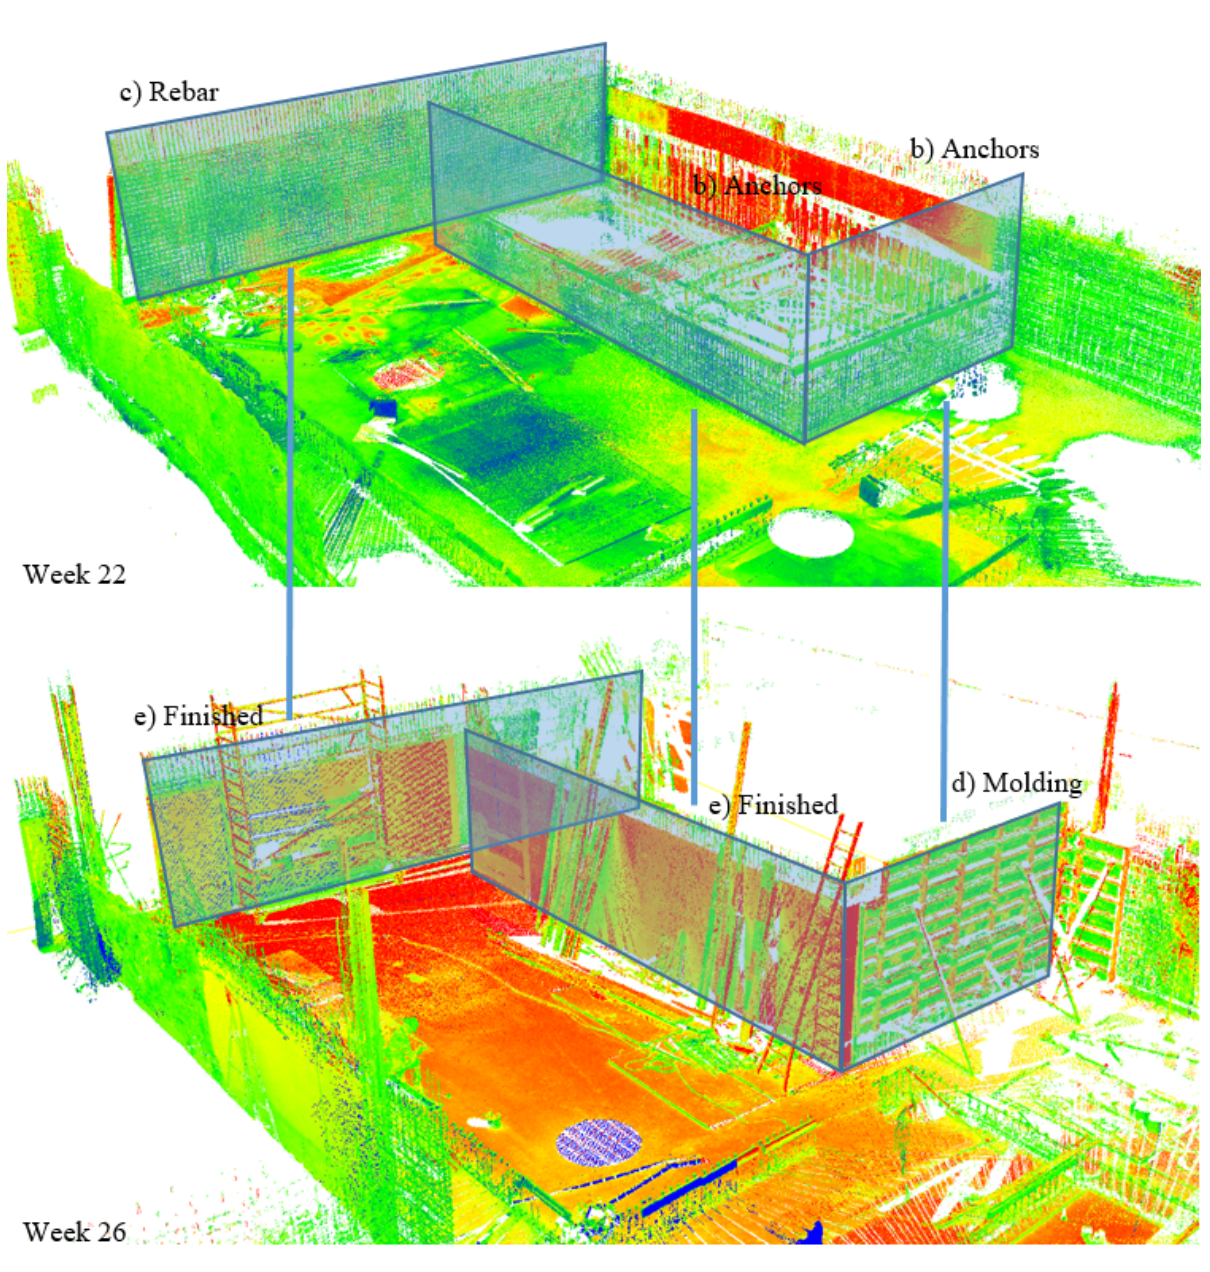
Figure 2: Example of the Percentage of Completion (PoC) of in-situ cast concrete walls in different epochs. 3 walls are depicted with varying PoC’s ranging from initial anchors to rebar to moldings and finally to finished structural object. The colorization of the point cloud is based on the SNR value of the scanner and is only used for